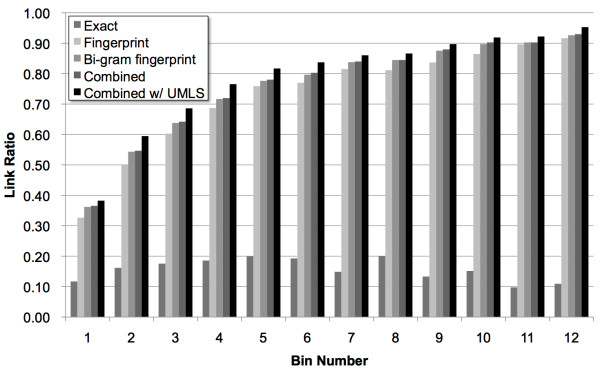
Link results. Link results for five methods/conditions: exact match, the key collision methods of fingerprint and bi-gram fingerprint, and the combined method with and without using the UMLS resources. The link ratio indicates the number of LFs with a link to their corresponding DBpedia titles divided by the total number of LFs at each bin.